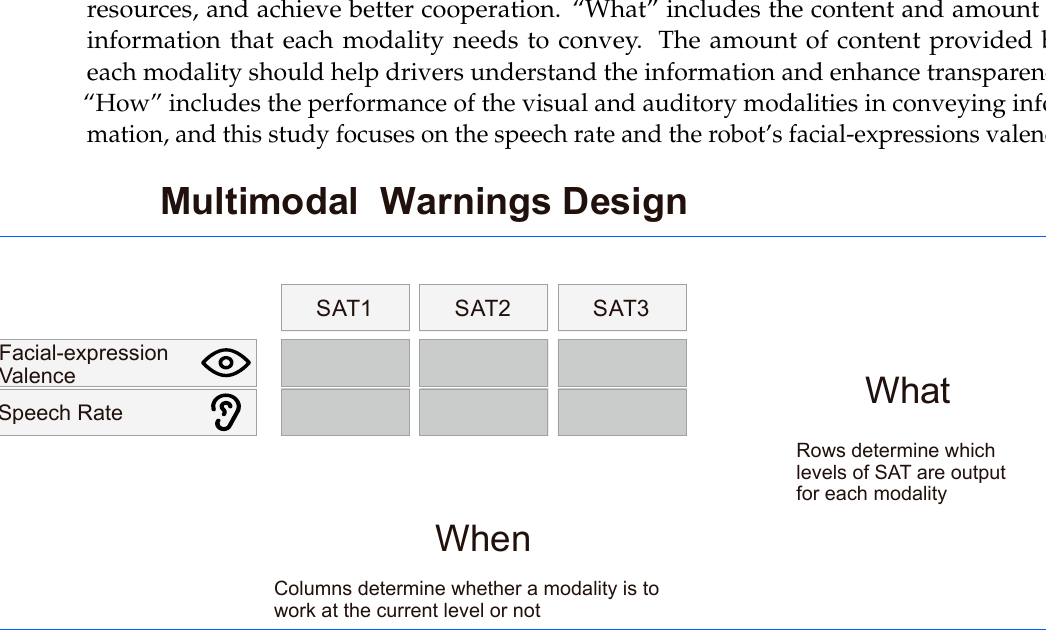
Figure 3. Design of “when”, “what”, and “how” of multimodal warnings of an in-vehicle robot.